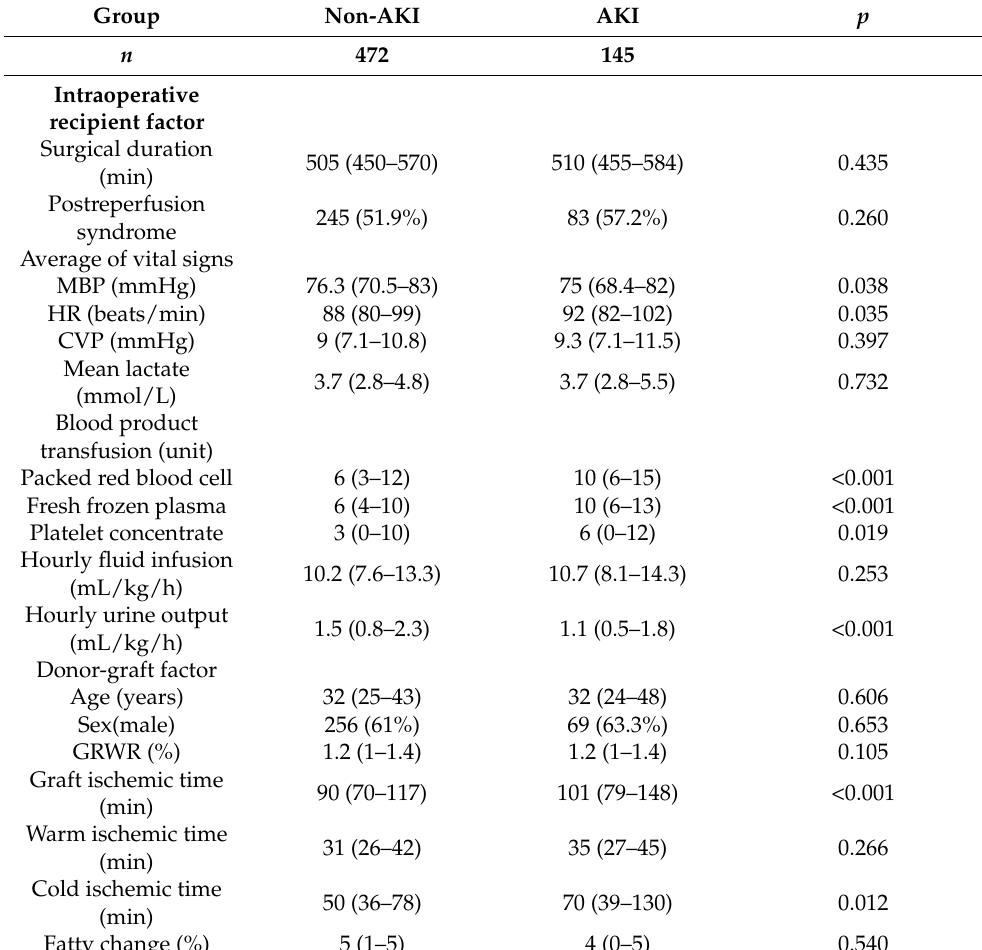
Table 2. Comparison of intraoperative recipient and donor clinical factors between the non-AKI and AKI